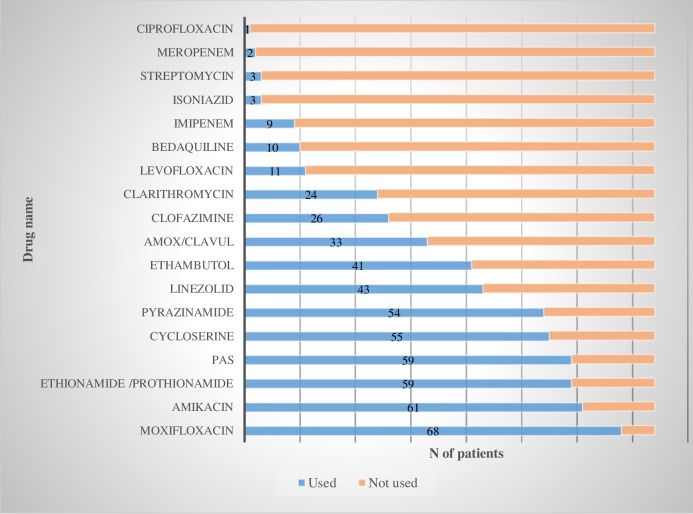
Regimen composition of 74 patients with MDR TB.